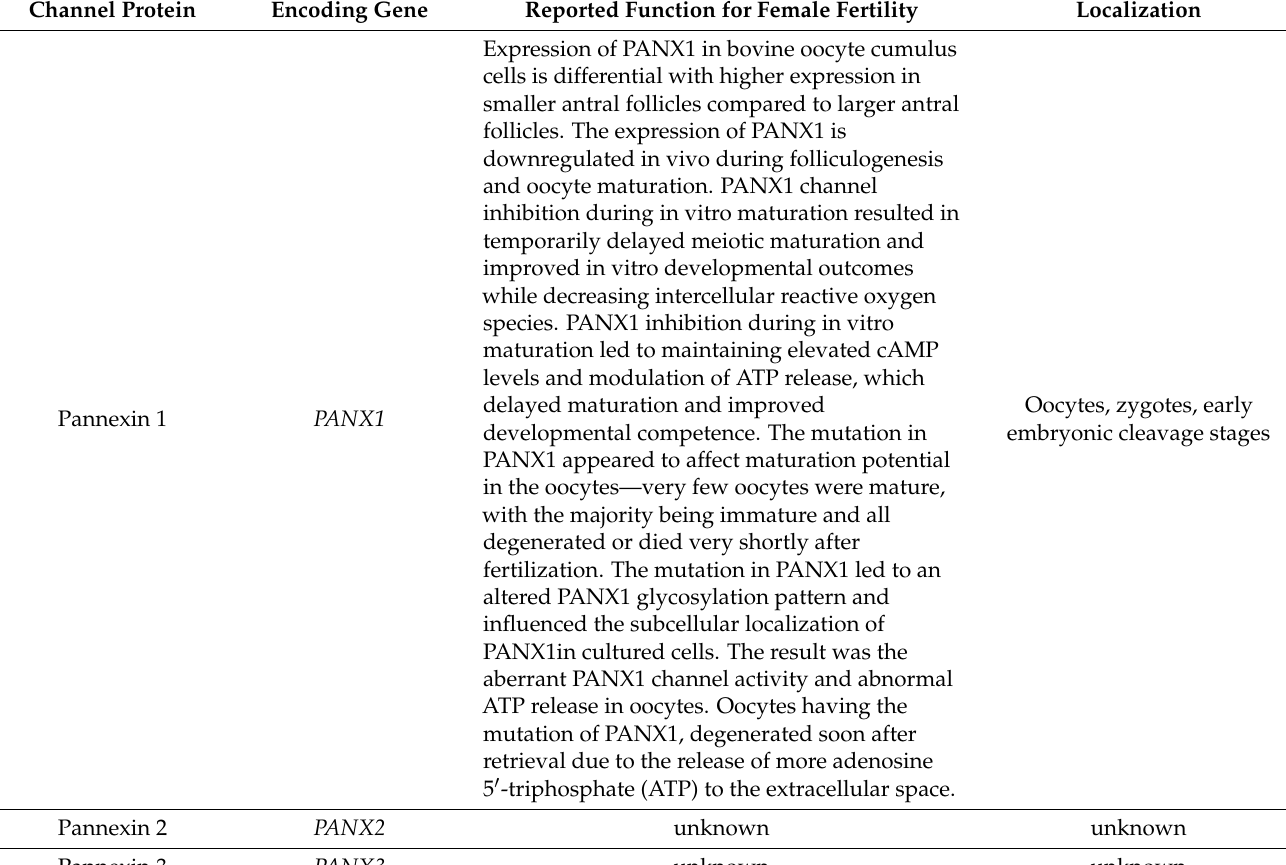
Table 2. Pannexins involved in oocyte development and female fertility. See text for references. Channel Protein Encoding Gene Reported Function for Female Fertility Localization